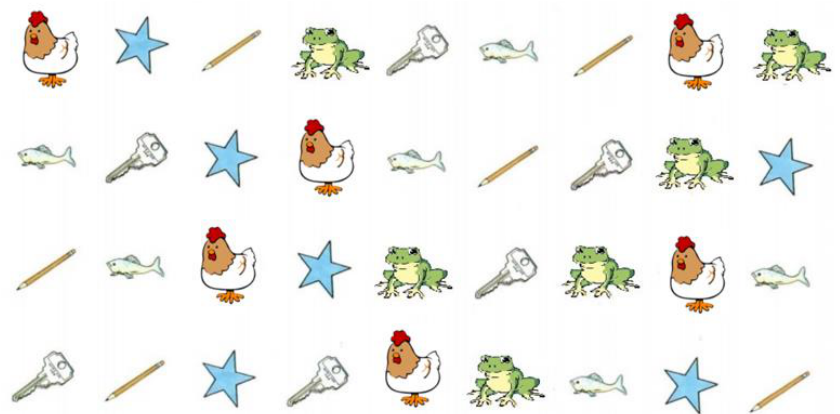
Figure A2. Serial Object Rapid Automatized Naming.